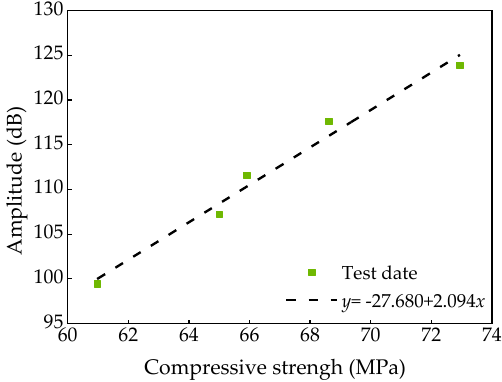
Figure 9. Relationship between amplitude and compressive strength.